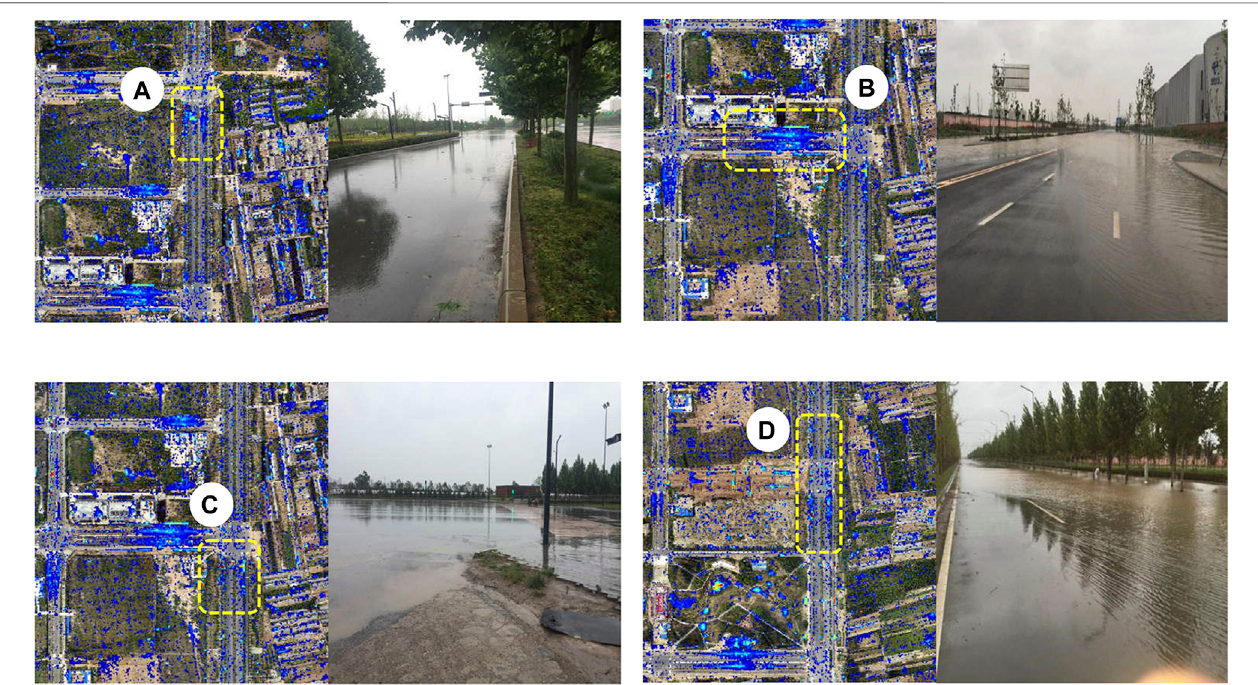
FIGURE 5 | The comparison of fi eld pictures and simulated results: the labels “ A, B, C, and D ” represent four inundation points, and the yellow dashed box represents the study area of inundation.